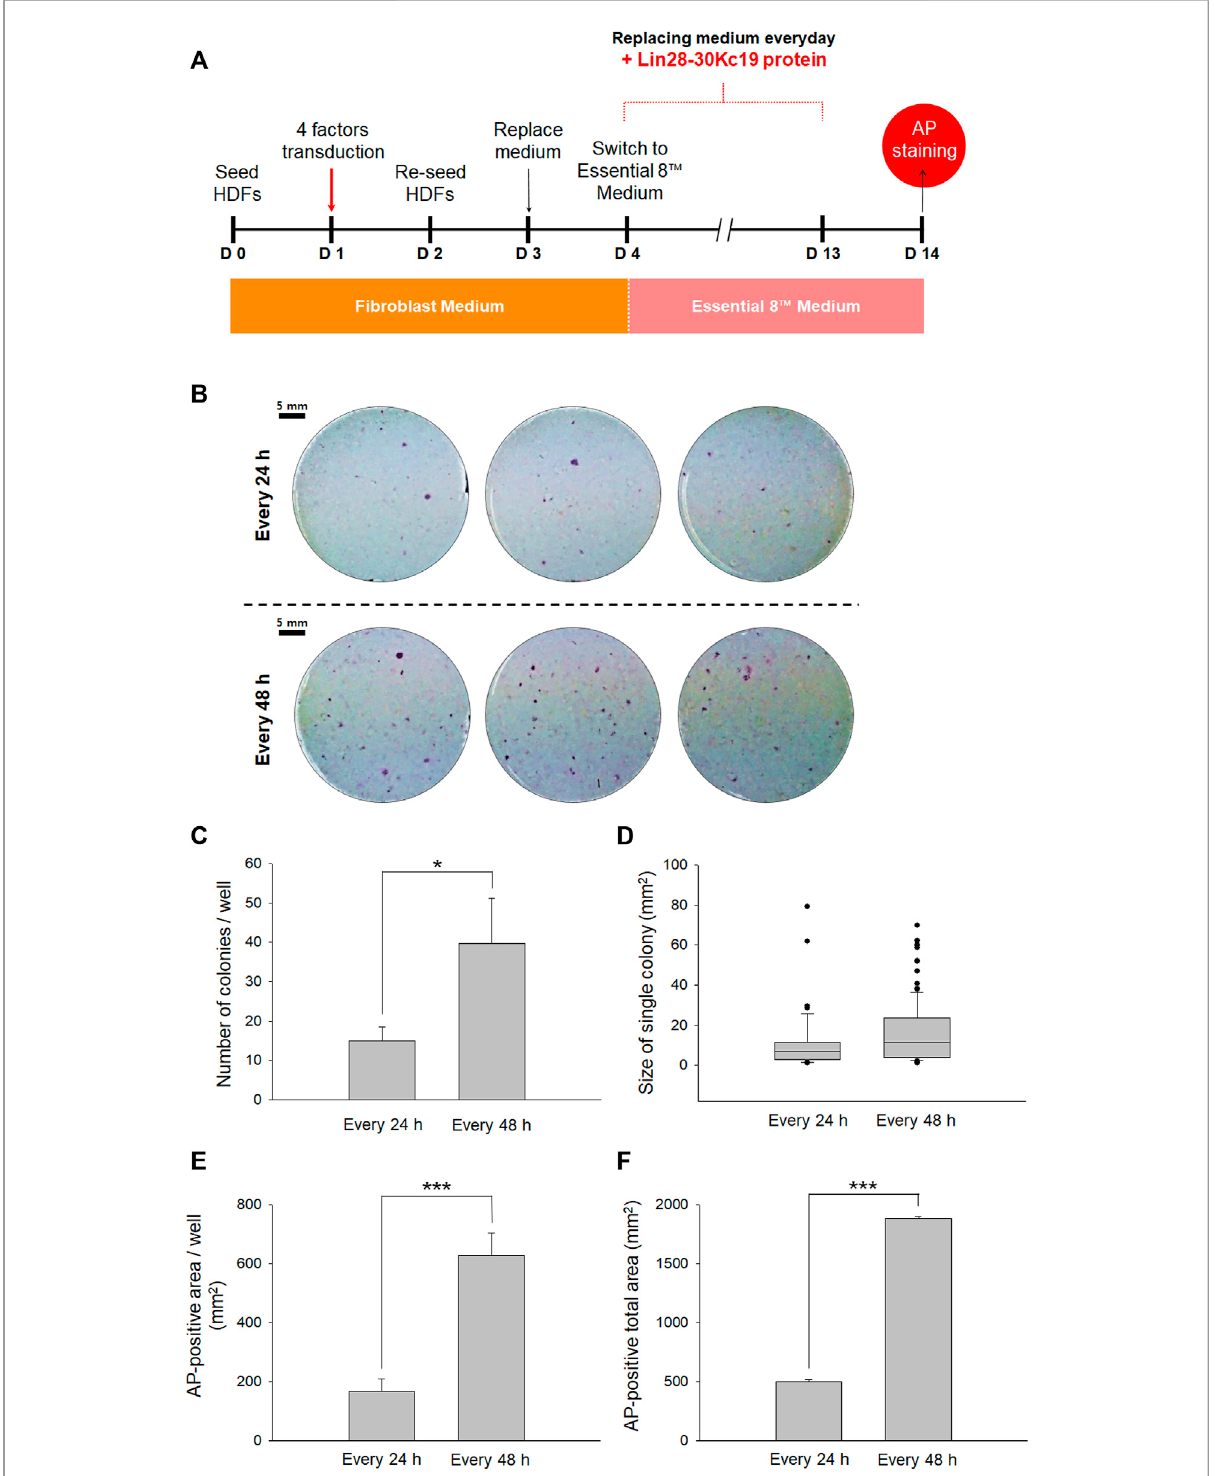
Optimal protein treatment interval for reprogramming fi broblasts to hiPSCs. (A) Timeline for determining the optimal interval of the protein treatment. From Day 4, the cell culture medium was switched from a fi broblast medium to an Essential 8 ™ medium, and the Lin28-30Kc19 protein was treated every 24 or 48 h, respectively. Then, the cells were analyzed by AP staining on day 14. (B) Naked eye images of the AP-stained cells treatedwiththeLin28-30Kc19 proteinfor every24or48 h,respectively. Scalebarsindicate 5 mm. (C) NumberofAP-stained